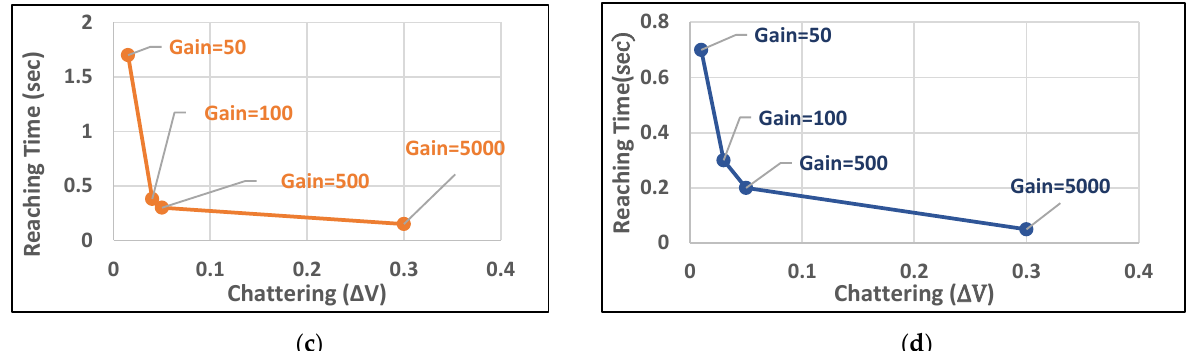
Figure 5. Trade-off between reaching time and chattering on different gain values: ( a ) PRERL [27], ( b ) RRL [29], ( c ) EERL [24], ( d ) proposed C-ERL-RSS.